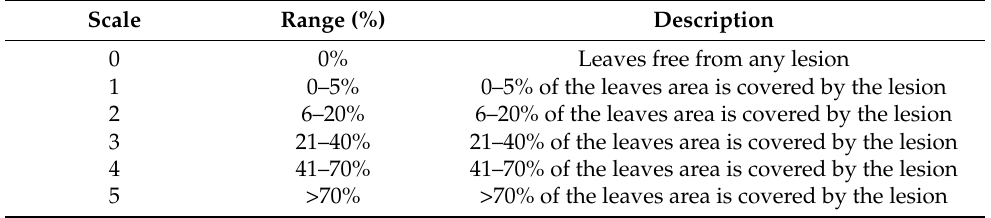
Table 5. Scale used in the evaluation of BLB disease severity under glasshouse condition. Scale Range